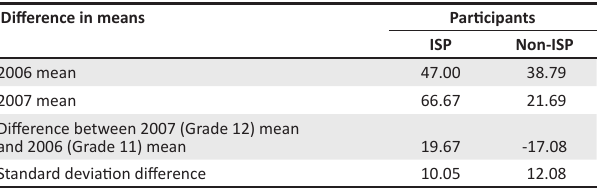
TABLE 6: Case study – Difference in means of Grade 11 and Grade 12 end-of- year marks for